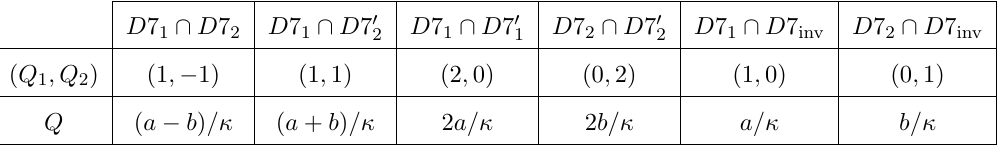
Table 1 . U(1) charges for generic a; b (see